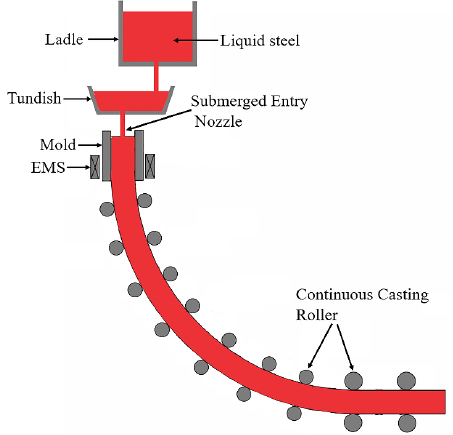
Figure 1. Schematic of curved continuous casting process.